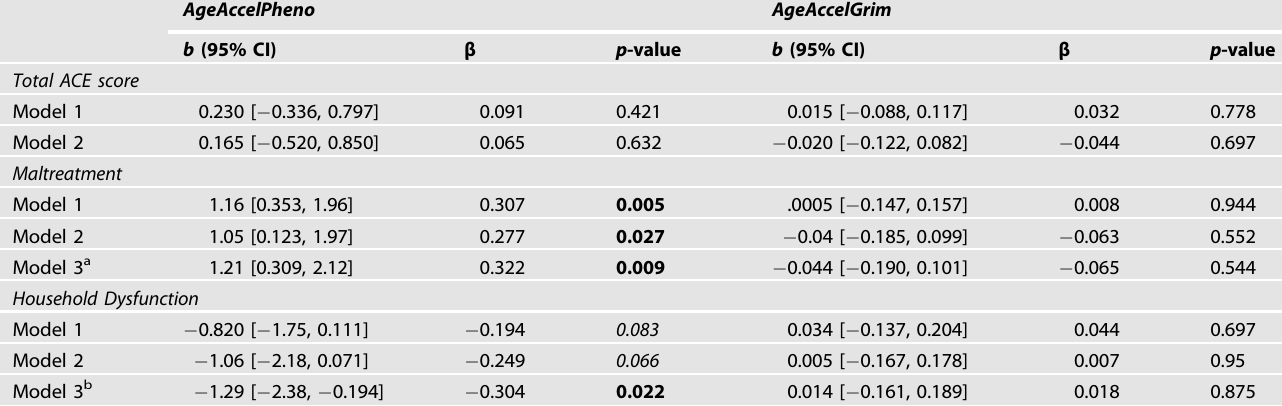
Table 3. Associations of ACE scores (Total, Maltreatment, Household Dysfunction) with Biological Aging.